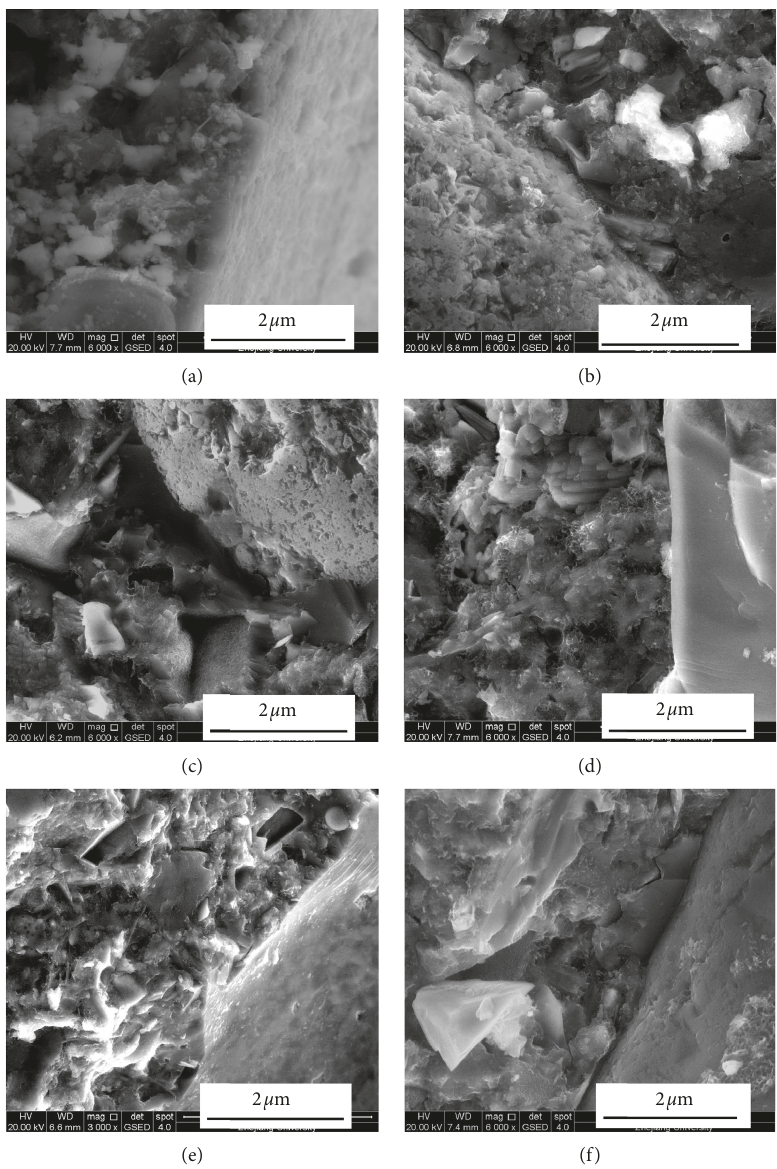
Figure 15: SEM images of ready-mixed concrete with different water contents and storage periods. (a) WC1.5-SP3. (b) WC1.5-SP7. (c) WC1.5-SP15. (d) WC1.5-SP30. (e) WC2.0-SP30. (f)